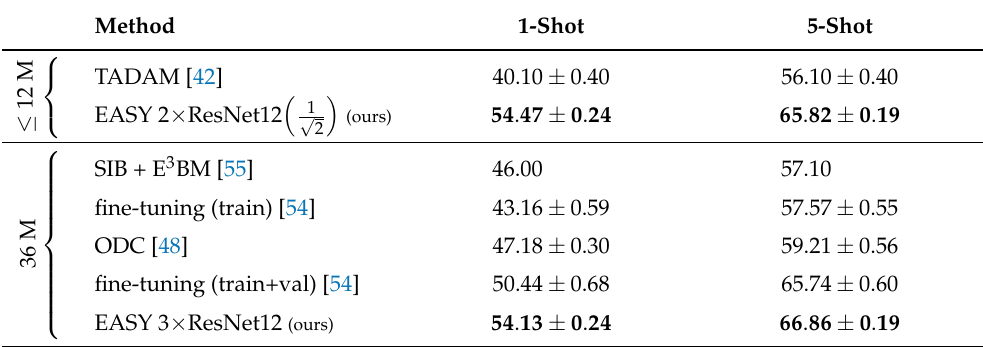
Table 8. The 1-shot and 5-shot accuracy of state-of-the-art methods and the proposed solution on FC-100 in the transductive setting.